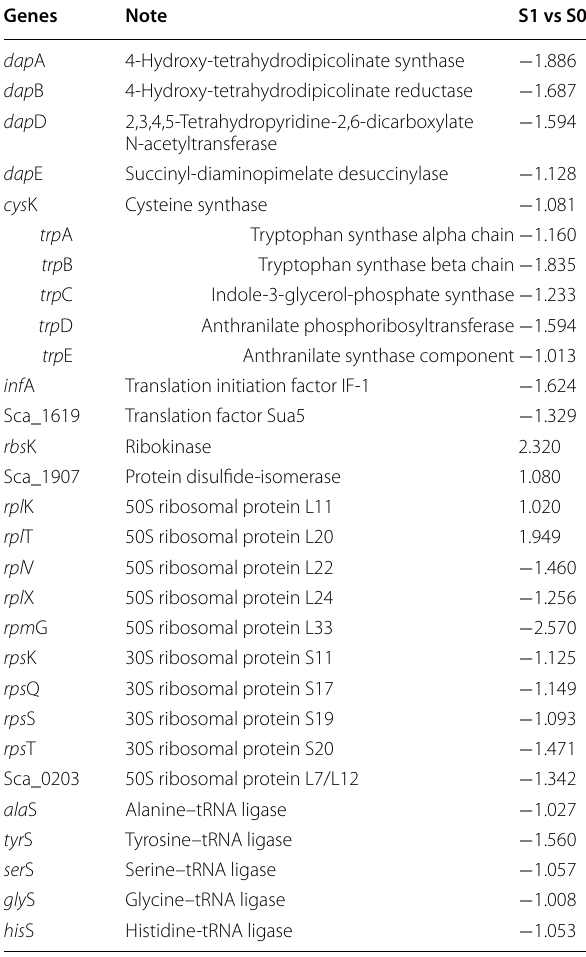
Table 5 DEGs related to amino acids and proteins Genes